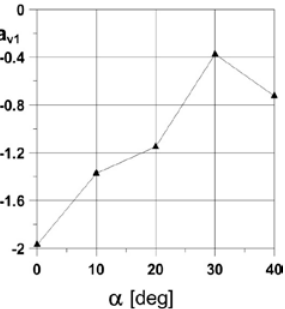
Fig. 14. Side force derivative of vertical stabiliser versus sideslip and angle of attack